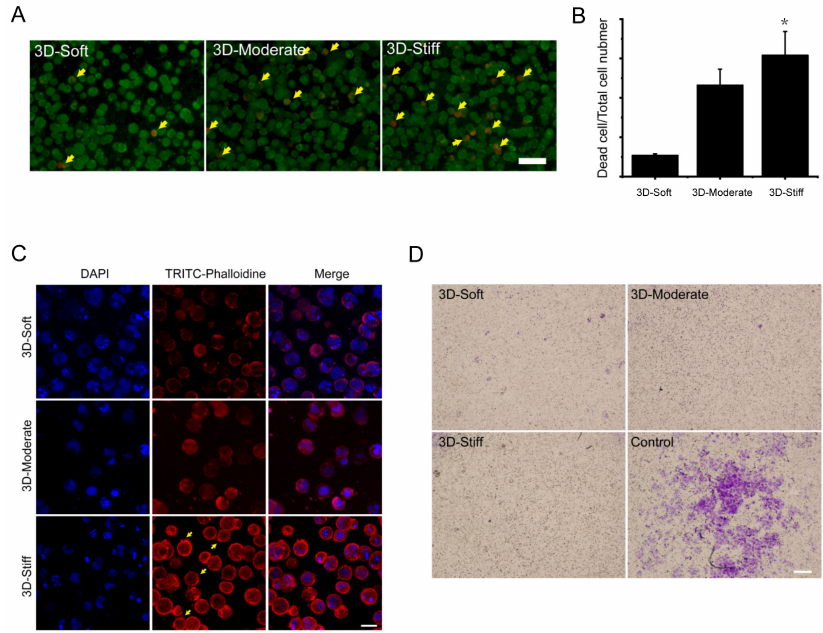
Figure 7. Live / dead assay for hepatocytes cultured on 3D soft, moderate and sti ff substrates for 48 h. ( A ) Fluorescence images of live / dead cells staining. Calcein-AM (green) indicates live cells, while PI (red) indicates dead cells, bar = 40 µ m. ( B ) Statistics of dead cell ratio (dead cell / total cell). Compared to the soft group. Data presented as the mean ± SEM ( n = 3). * represents p < 0.05. ( C ) Cytoskeleton image of hepatocytes cultured on 3D soft, moderate, and sti ff substrates. Cells were stained for TRITC (tetramethyl rhodamine isothiocynate)-phalloidine (red) and cell nucleus (blue), bar = 25 µ m. ( D ) Images of the migration of hepatocytes grown in di ff erent sti ff ness 3D gel, no gel group as control, bar = 200 µ m, n =